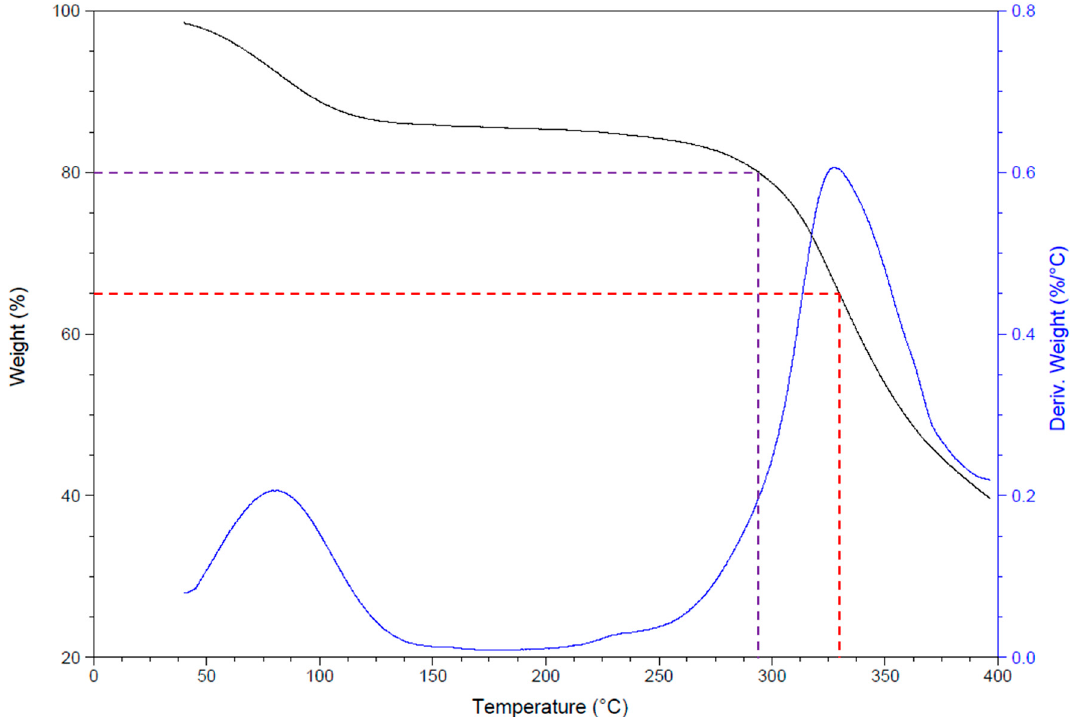
Figure 5. Thermogravimetry of the scaffold. The purple line indicates the loss of the first 20% of the sample mass ( T d20% ), and the red line indicates the temperature point for the half mass loss ( T d50% ).